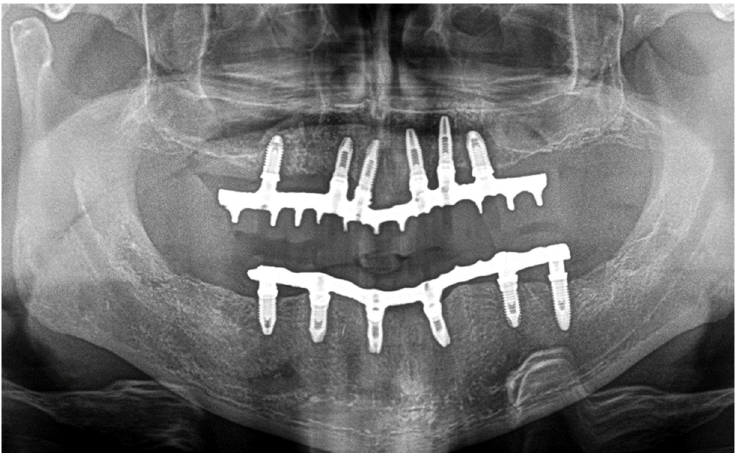
Figure 9. Prosthetic rehabilitation with a fixed implant-supported prosthesis and final occlusion.